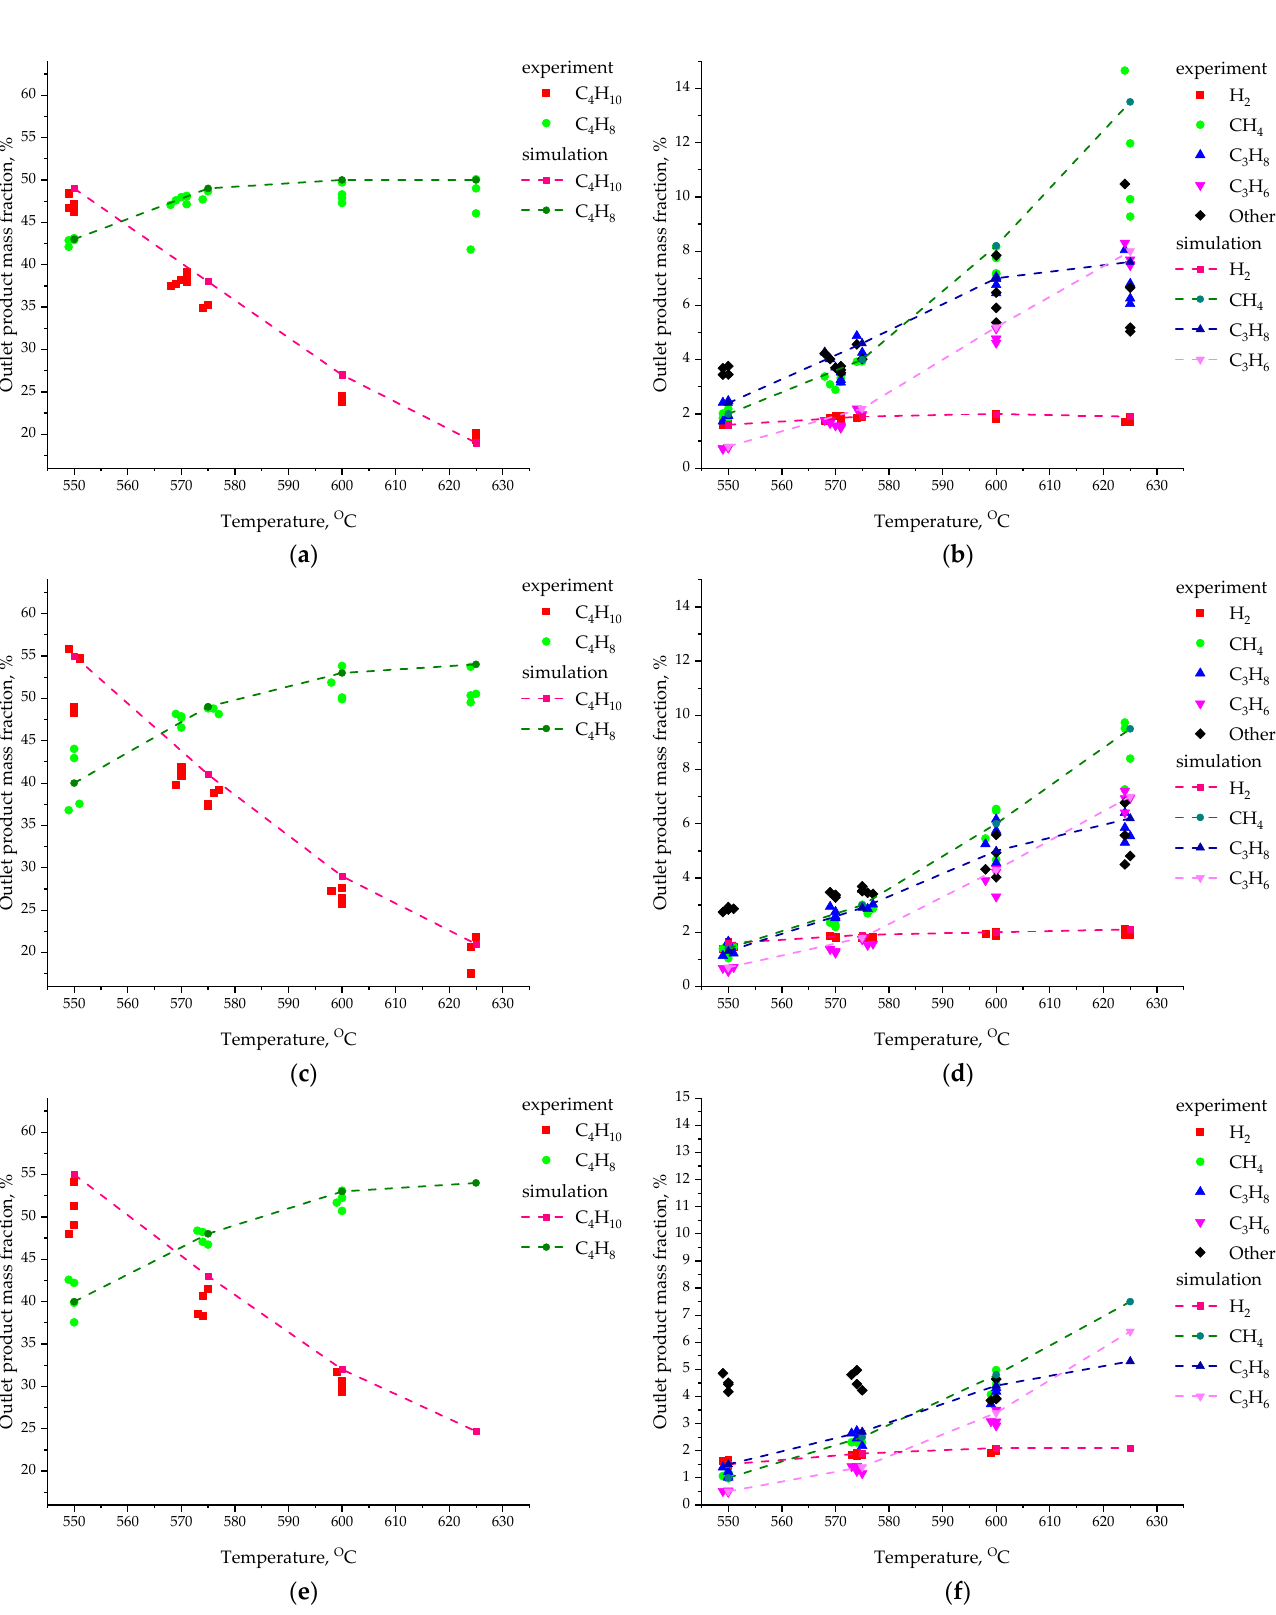
Figure 8. The mass fraction of reaction products for the case of catalyst mass of 100 g: ( a ) C 4 H 10 and C 4 H 8 at v = 0.008 m/s; ( b ) H 2 , CH 4 , C 3 H 8 , C 3 H 6 at v = 0.008 m/s; ( c ) C 4 H 10 and C 4 H 8 at v = 0.012 m/s; ( d ) H 2 , CH 4 , C 3 H 8 , C 3 H 6 at v = 0.012 m/s; ( e ) C 4 H 10 and C 4 H 8 at v = 0.016 m/s; and ( f ) H 2 , CH 4 , C 3 H 8 , C 3 H 6 at v = 0.016 m/s.